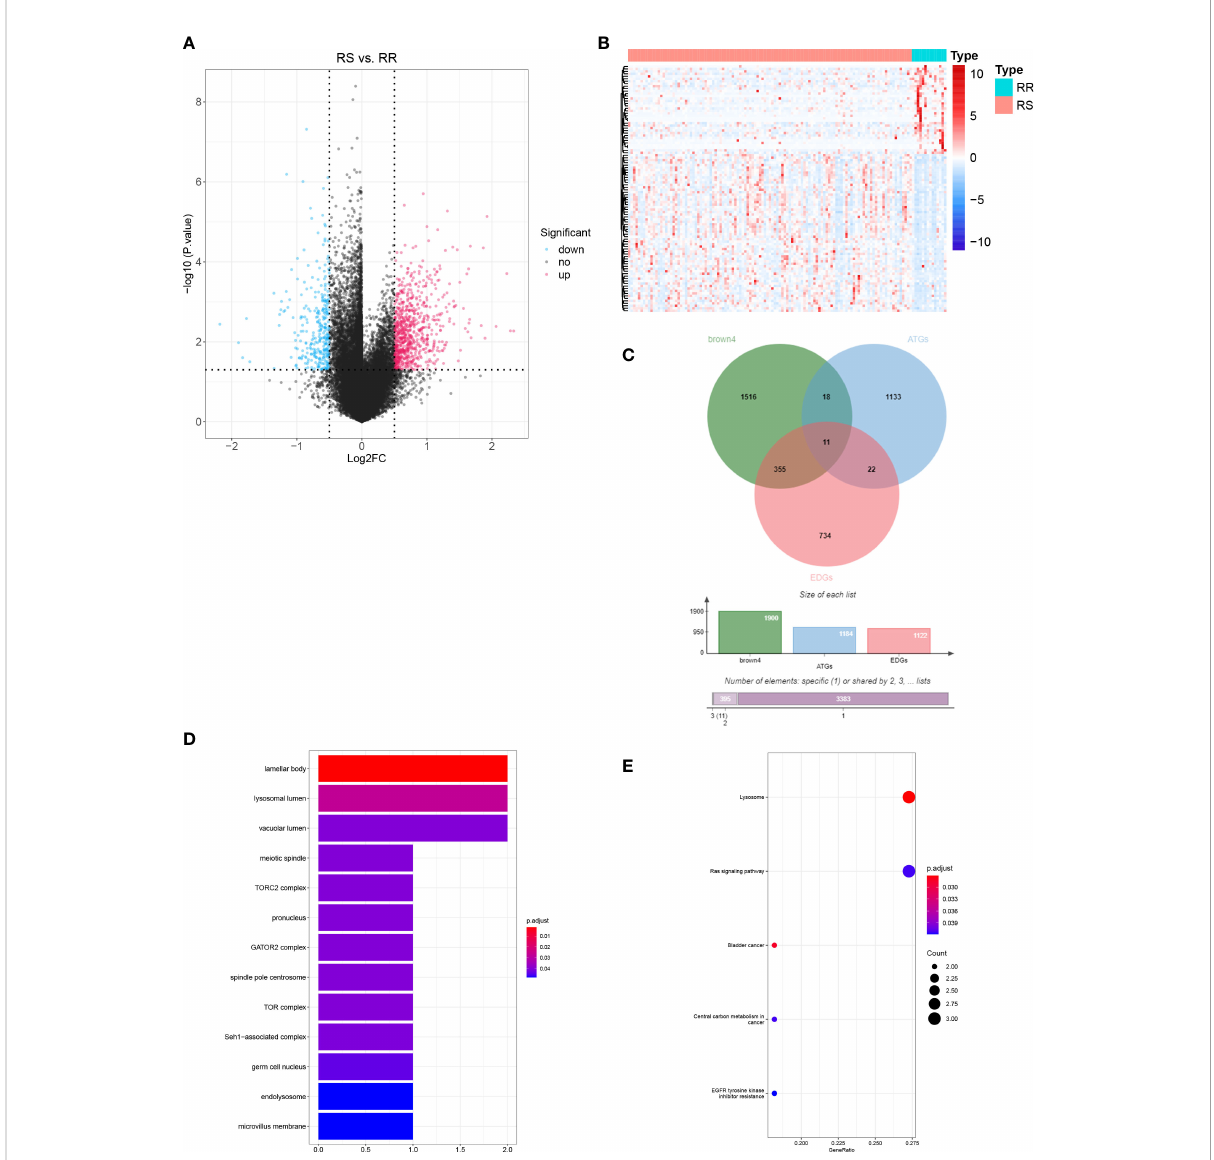
FIGURE 3 Identi fi cation of DERRAGs in LUAD. (A) Volcano map of RS vs. RR differentially expressed genes (DEGs) in LUAD. (B) Heat map of RS vs. RR DEGs in LUAD (Top 100). (C) The Venn diagram of DEGs, ATGs, and key module genes (brown4). (D) GO enrichment analysis of DERRAGs. (E) KEGG enrichment analysis of